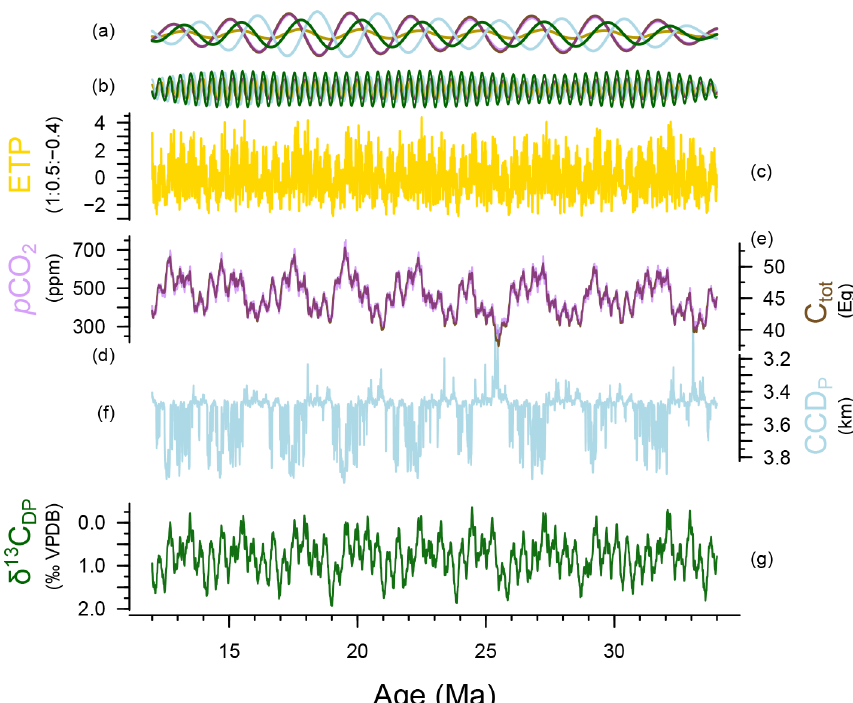
Figure 2. LOSCAR model output time series for orbitally forced carbon burial with orbital forcing strength α = 0 . 5 and noise level 0.2. (a) 2.4Myr (0 . 42 ± 0 . 15Myr − 1 ) and (b) 405kyr (frequency of 2 . 46 ± 0 . 15Myr − 1 ) bandpass filters are shown (same colours, arbitrary y axis). (c) The ETP (1 : 0 . 5 : − 0 . 4) construct used as orbital forcing in this scenario (gold). (d) Atmospheric CO 2 (purple, parts per million volume, ppm) and (e) the total exogenic carbon inventory (brown, Eg (10 18 g)). (f) Pacific CCD (blue, km; note the cutoff y axis due to large outliers, explained in Sect. S1) (g) Deep Pacific δ 13 C (green, ‰ VPDB, reversed axis). Deep Pacific temperature ( ◦ C), and DIC of the deep Pacific model output are omitted from this plot because their pattern mirrors that of C tot and p CO 2 (Fig.